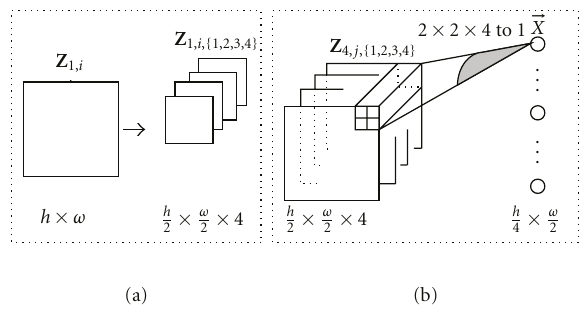
Figure 3: The sub-sampling operations of Stage 1 (a) and Stage 2